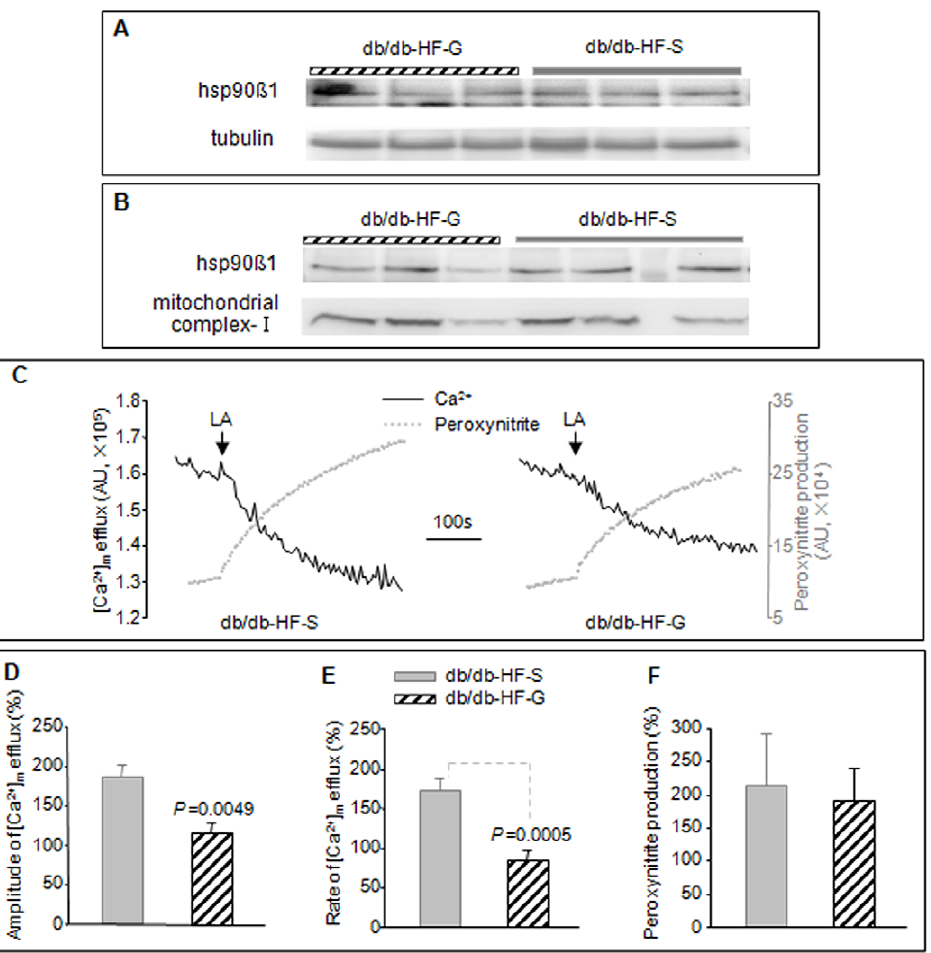
Figure 4. Impact of 17-DMAG on hsp90 b 1, [Ca 2 + ] m , and peroxynitrite generation in the kidney. Western blot analysis was performed to assess hsp90 b 1 in kidney homogenate ( A ) and isolated mitochondria ( B ) of HFD-fed db/db mice with 6 animals per group. Linoleic acid (LA)-induced [Ca 2 + ] m efflux and peroxynitrite generation ( C–F ) in kidney mitochondria were measured.